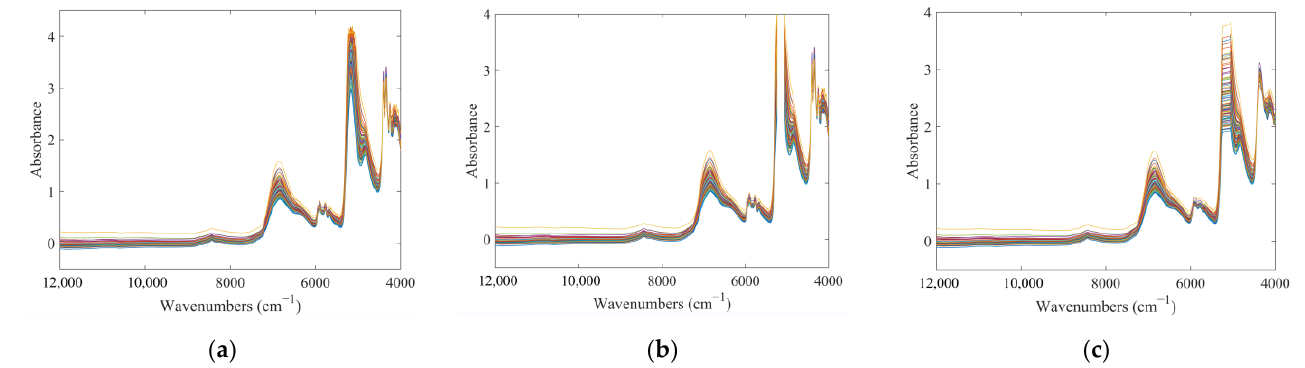
Figure 2. NIR absorbance spectra. ( a ) the raw NIR absorbance spectra; ( b ) processed spectra; ( c ) SG smoothing processed spectra. Different colors represent different samples.